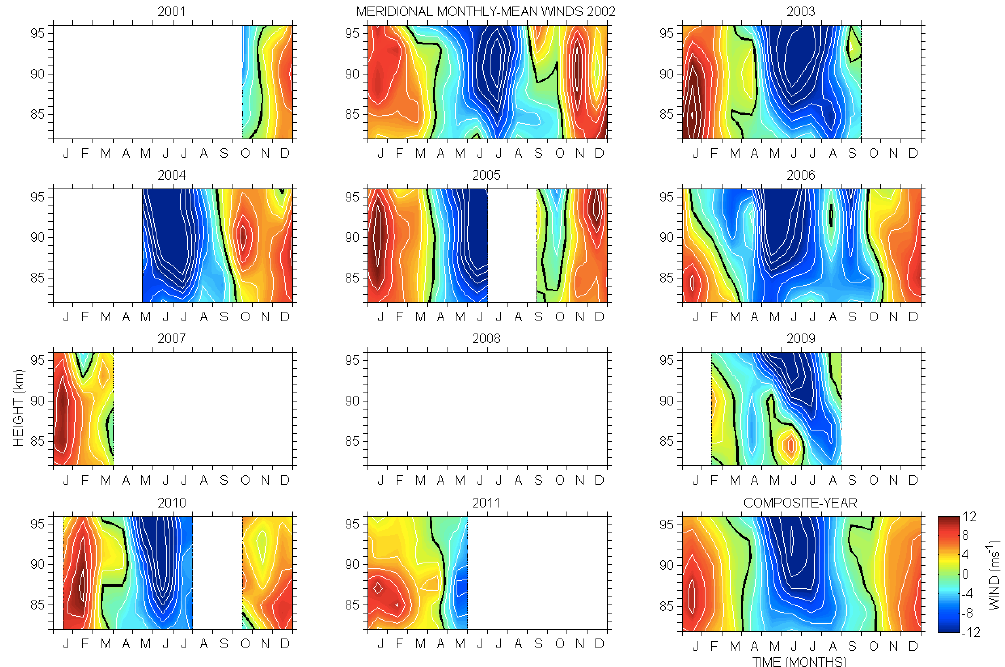
Fig. 3. Monthly-mean meridional winds over Ascension Island for the years 2001–2011 and the composite years. The zero wind contour is indicated in black, and the white contours are in steps of 2ms − 1 .